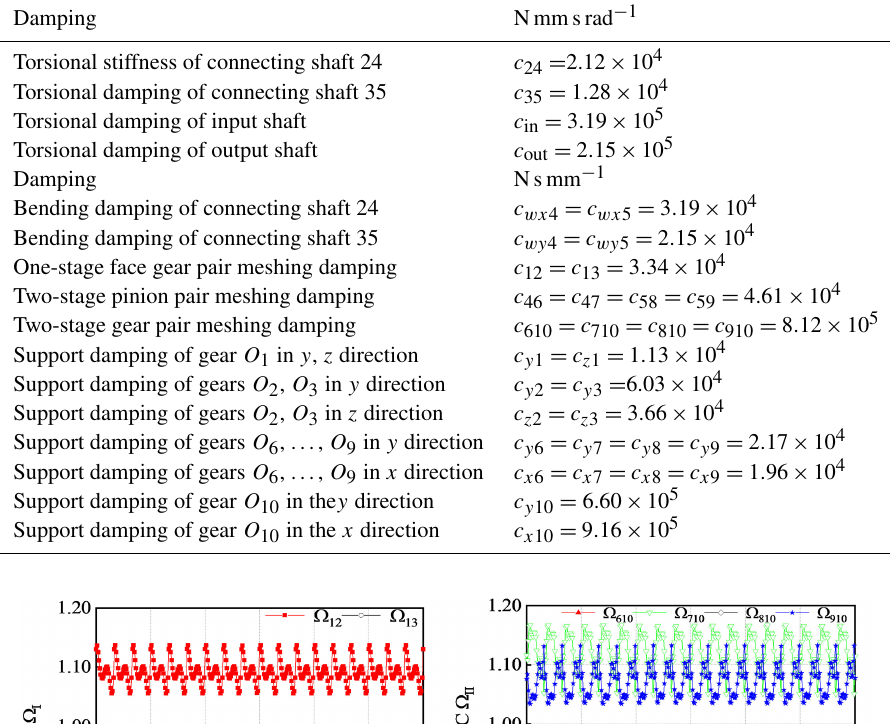
Table 3. Parameters of equivalent damping.